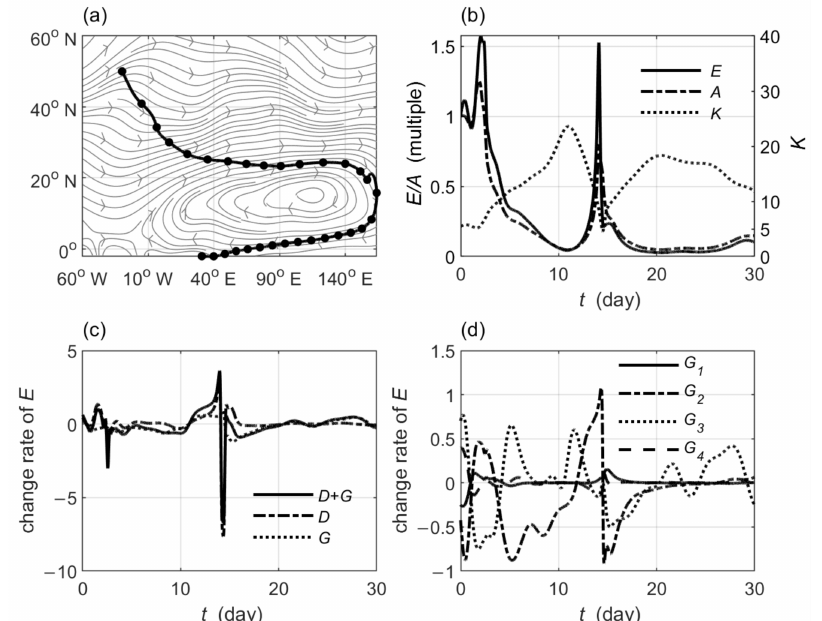
Figure 7. Ray path (solid black dots denoting the one day interval) of the wave (the source is set to 30 ◦ W, 50 ◦ N) with a period T = 30 days ( a ). The variations in wave energy ( E , solid line), amplitude ( A , dash-dotted line) and the total wavenumber ( K , dotted line) along the ray ( b ). The variations in the divergence of the group velocity (dash-dotted line, shortened as D ), the energy budget from the basic flow (dotted line, shortened as G ) and the sum of them (change rate of wave energy) along the ray ( c ). The variations in the four components of the energy budget from the basic flow (shortened as G 1 , G 2 , G 3 and G 4 , respectively, and their sum equals G ) along the ray ( d ). D and G ( G 1 , G 2 , G 3 and G 4 ) have been magnified 10 5 times to glory the